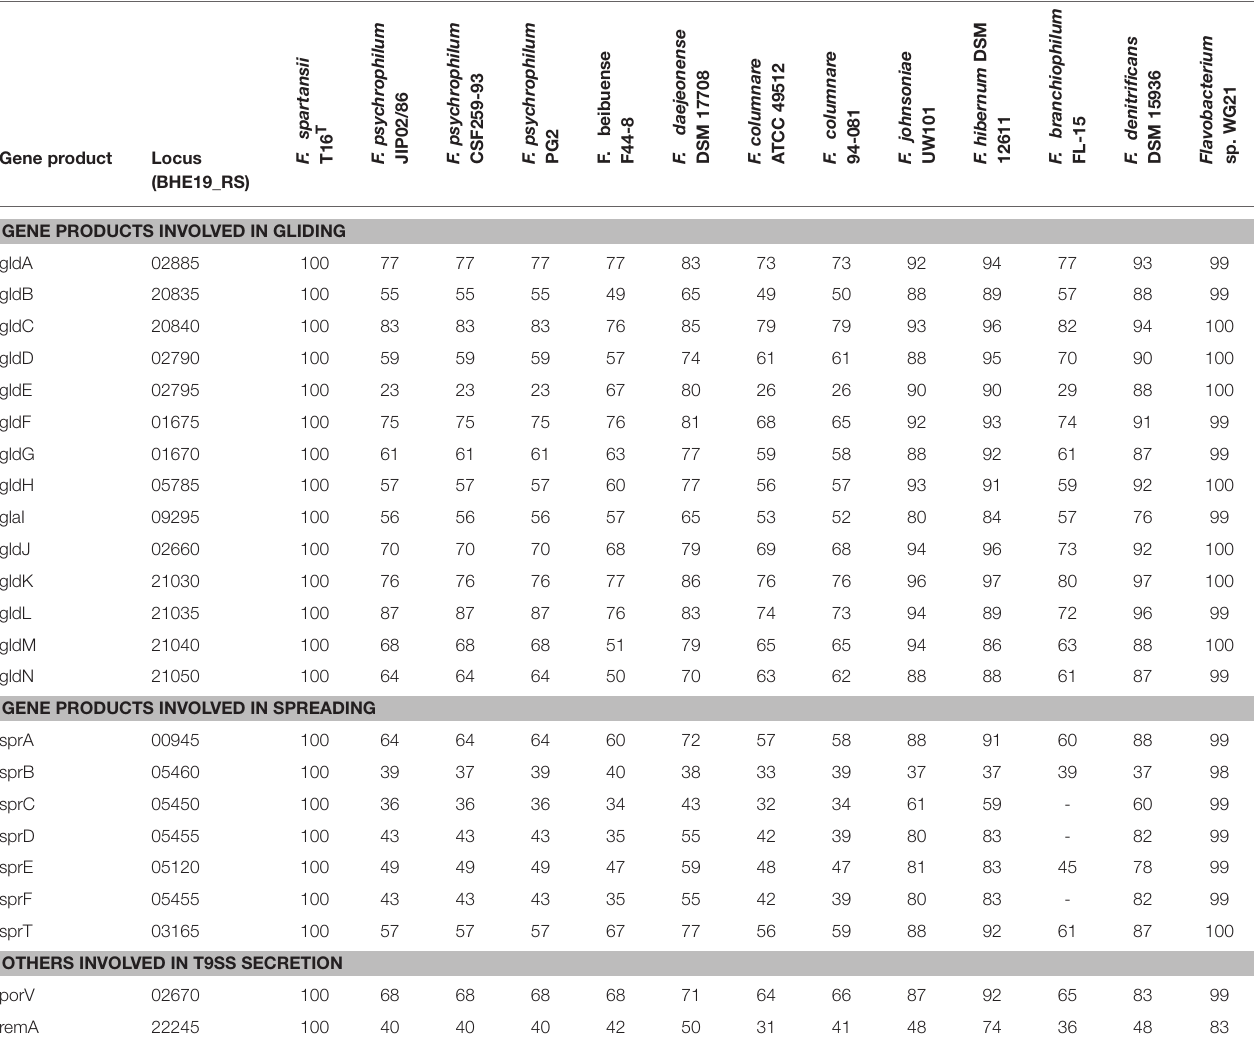
TABLE 6 | Comparation of gliding machinery in selected Flavobacterium spp. * .